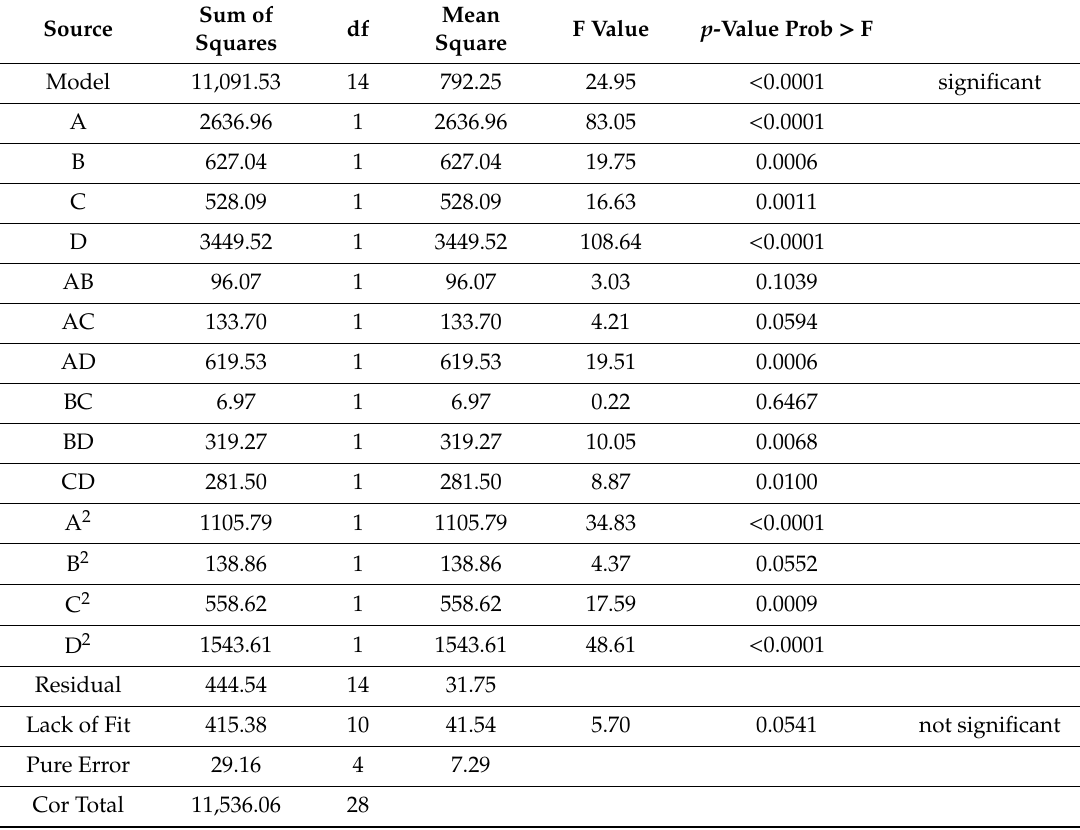
Table 4. Analysis of variance for the regression